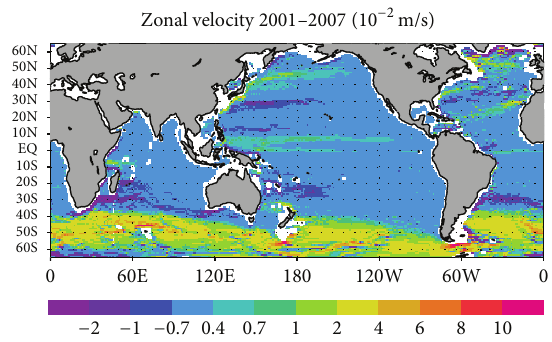
Figure 1: Annual mean zonal velocity at 1000dbar (eastward is positive) derived from Argo drift data during 2000–2010 [9].